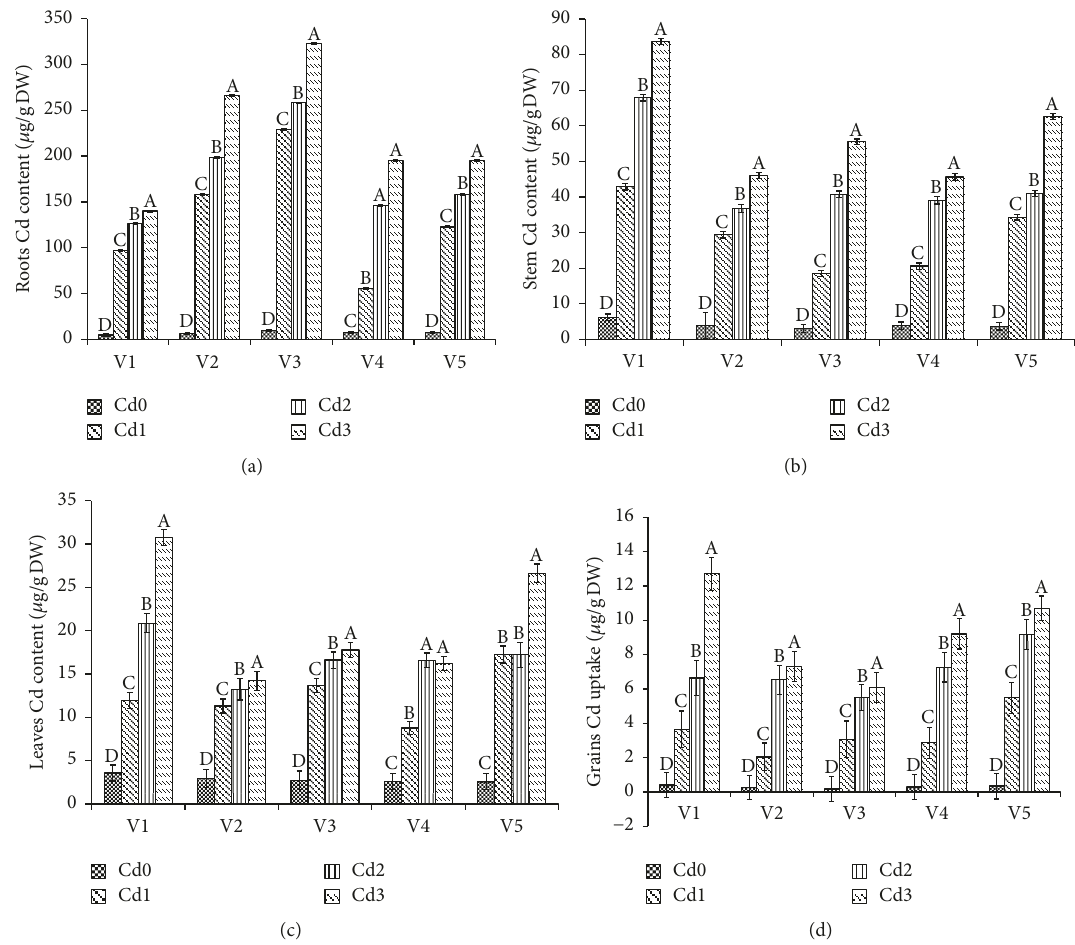
Figure 2: Cd accumulation in (a) roots, (b) stems, (c) leaves, and (d) grains of the five different rice cultivars under induced Cd stress at maturity stage. The values are representative of three replicated means per treatment ± SE. Different letters indicate significant differences between treatments at 𝑃 ≤ 0.05 ,